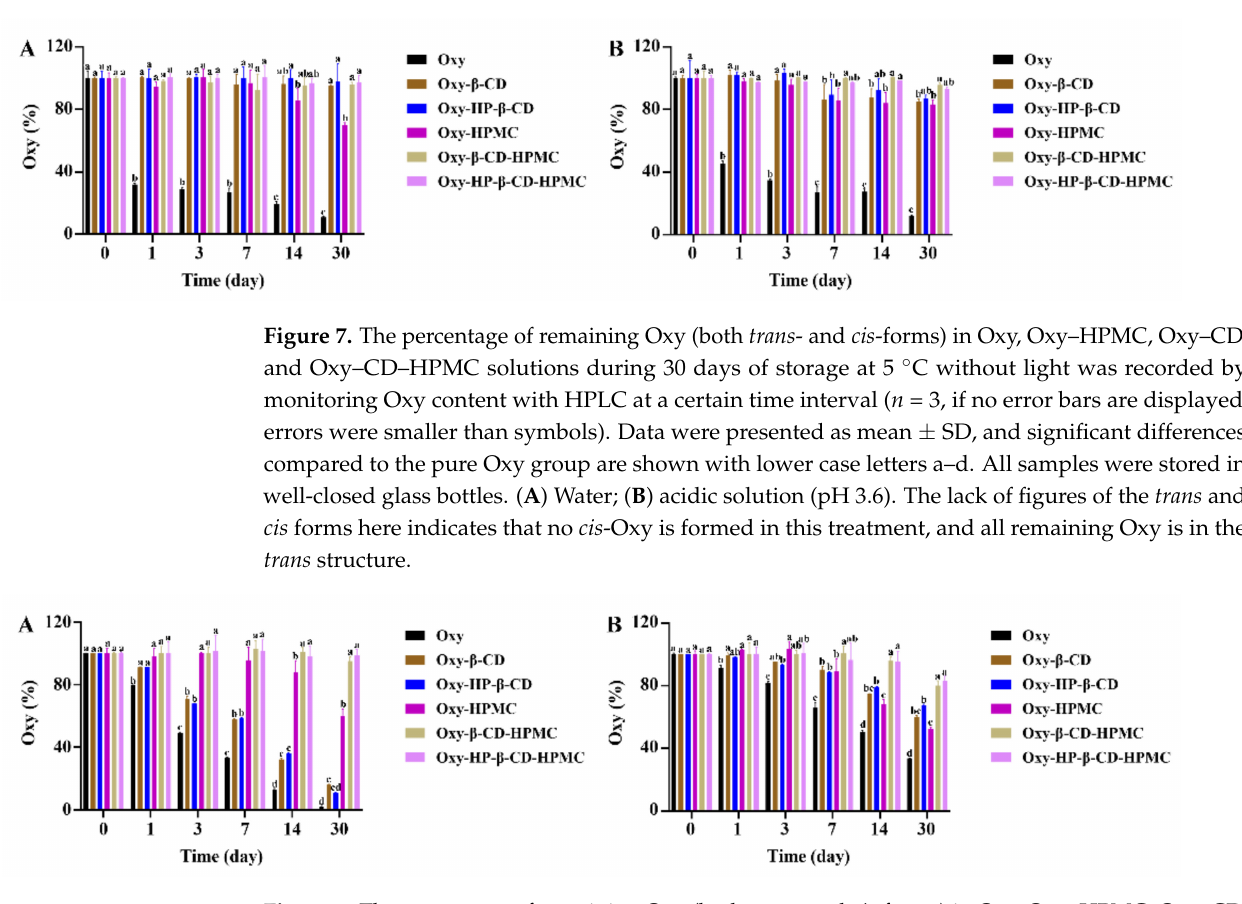
Figure 8. The percentage of remaining Oxy (both trans - and cis -forms) in Oxy, Oxy–HPMC, Oxy–CD, and Oxy–CD-HPMC solutions during 30 days of storage at 50 ◦ C without light was recorded by monitoring Oxy content with HPLC at a certain time interval ( n = 3, if no error bars are displayed, errors were smaller than symbols). Data were presented as mean ± SD, and significant differences compared to the pure Oxy group are shown with lower case letters a–d. All samples were stored in well-closed glass bottles. ( A ) Water; ( B ) acidic solution (pH 3.6). The lack of figures of the trans - and cis -forms here indicates that no cis -Oxy is formed in this treatment, and all remaining Oxy is in the trans